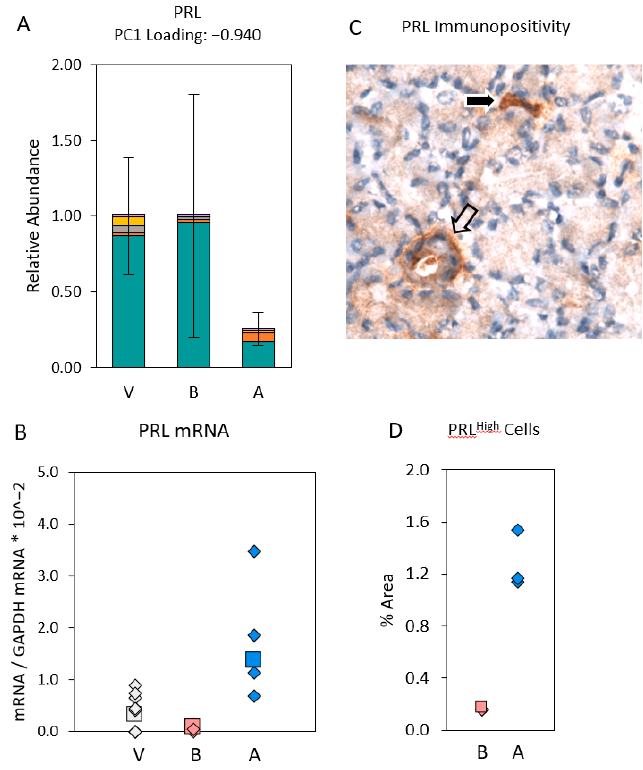
Figure 9. ( A ) Modeled abundances of mRNA for PRL in epithelial segment samples and immune cell samples dissected from the P.G5.B glands, the P.G5.A gland, and a V.G5 gland. Color code and error bars are as defined in Figure 6. ( B ) Measured abundances of mRNA for PRL (PRL mRNA / GAPDH mRNA) in all V.G5, P.G5.B, and P.G5.A glands. Glands selected for microdissection are indicated by large-font symbols. ( C ) Frozen section stained for prolactin (PRL) immunoreactivity. The black arrow indicates an intensely immunopositive cell (PRL High cell) in the interacinar space. The white arrow indicates a duct. ( D ) Percent areas occupied by PRL High cells in three P.G5.B glands and three P.G5.A glands.